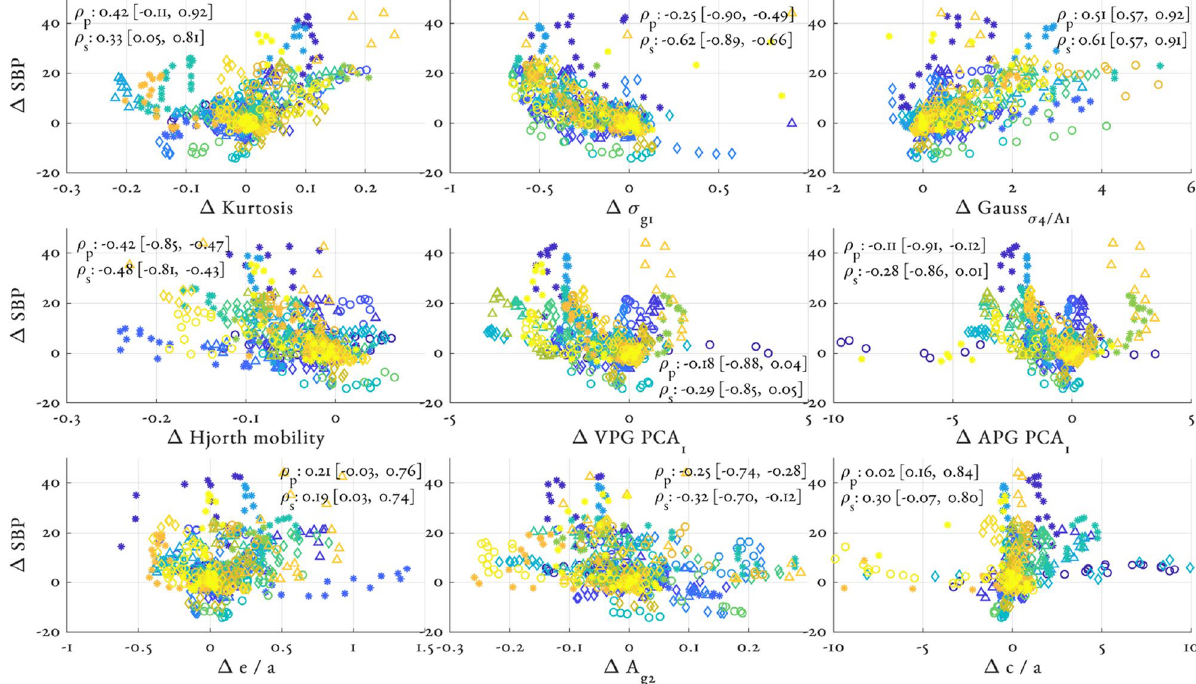
Figure 6. Relationship between top 9 ranking, non-demographic, features from the RF PPG+ECG model and (cid:31) SBP. Individual participants are colour and marker coded. Inter Pearson’s ρ p and Spearman’s ρ s correlation coefficient are shown as median and upper and lower quartiles. Additionally the 1st and 3rd quartiles of the participant- wise correlation coefficients are shown. Note that feature values have been both subtracted and divided by their value at